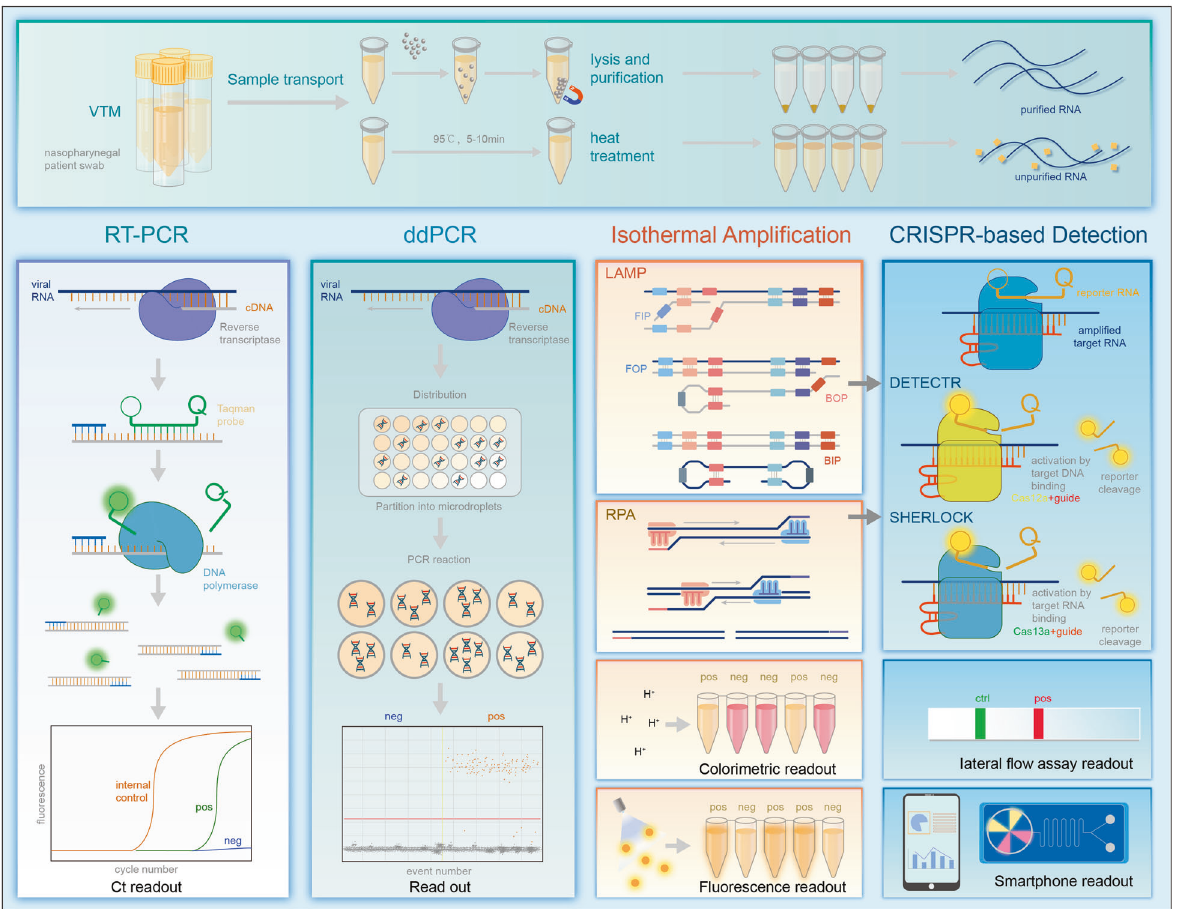
Fig. 2 Summary of the nucleic acid ampli fi cation testing. The nucleic acid of SARS-CoV-2 is extracted by magnetic beads absorption or heat treatment. Ampli fi cation is performed and signals could be detected using the special instrument for rRT-PCR, ddPCR, LAMP, and RPA. Isothermal ampli fi cation and CRISPR-based methods can be read out by a color change, lateral- fl ow assay, fl uorescence signal or portable electronic